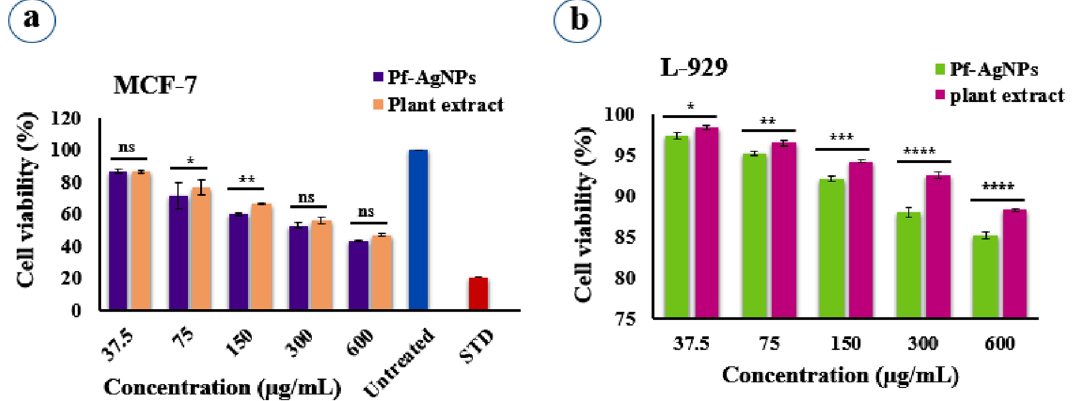
Figure 7. Cell viability of MCF-7 ( a ) and L-929 ( b ) after treatment with different concentrations of Pf-AgNPs and the extract of Perilla frutescens . Error bar represents standard deviation of